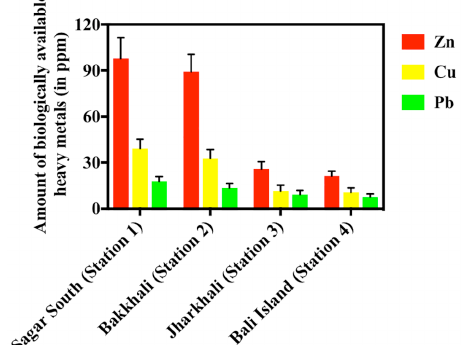
Figure 4. Biologically available heavy metals (HMs) present in the ambient soil of the selected mangrove associate species Figure 5. Heavy metal bioaccumulation within the vegetative sampled from four different study sites in the Hooghly-Matla tissues of Suaeda maritima sampled from the selected study estuarine complex of Indian Sundarbans. Error bars indicate sites in the Hooghly-Matla estuarine complex of Indian standard deviation from the mean of triplicate values. Two-way Sundarbans. Error bars indicate standard deviation from the ANOVA shows that the p-value is < 0.1 between stations and mean of triplicate between HMs